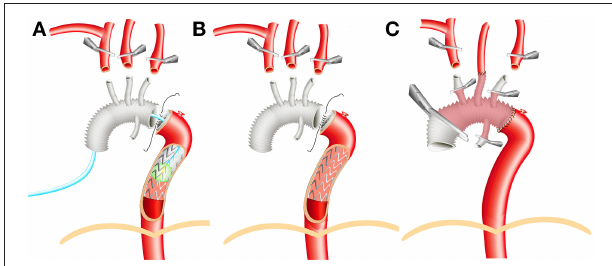
FIGURE 1 | Illustration of surgical technique. (A) Aortic balloon occlusion. (B) Conventional total aortic arch replacement (TAR) with frozen elephant trunk (FET). (C) Aortic reconstruction before